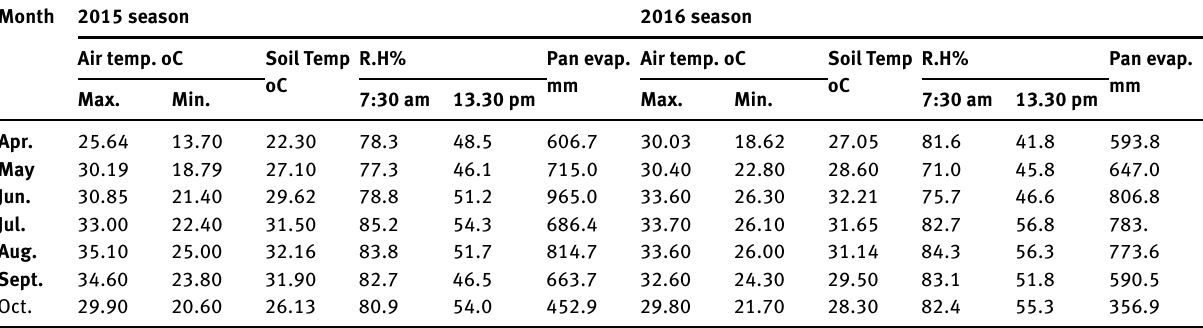
Table 2: Monthly means of both air and soil temperatures, relative humidity and pan evaporation during the two growing season, 2015 and